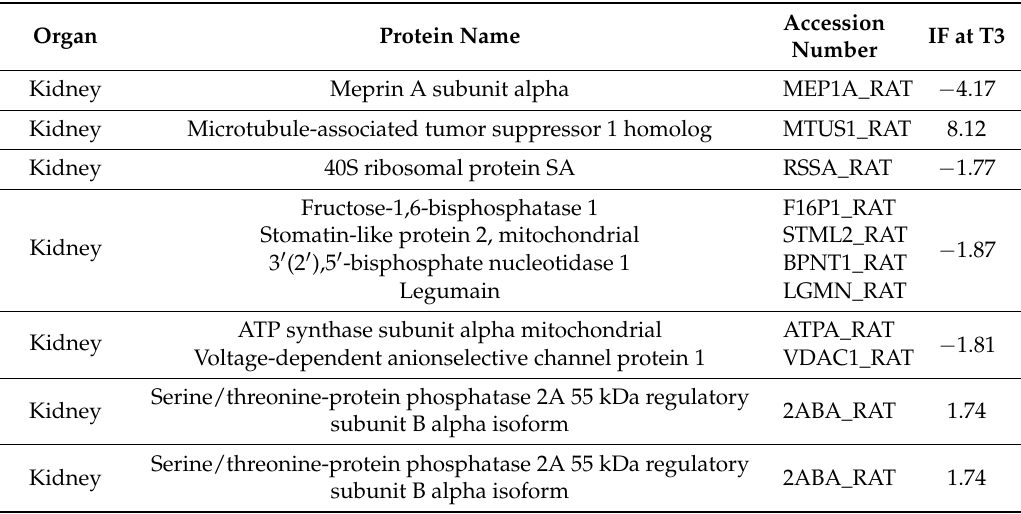
Table 4. Significantly regulated proteins 3 days after hyperoxia (T3) in different organs. Positive values express up-regulation ( n = 7), negative values down-regulation ( n =